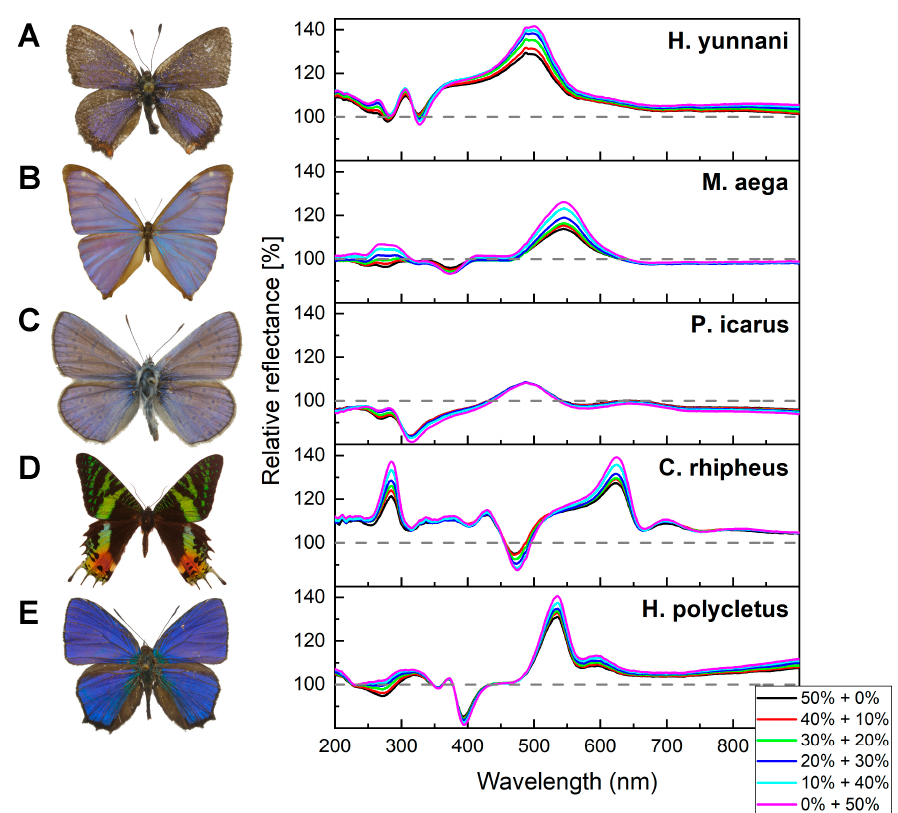
Figure 4. Optical responses of the wings of five species (photographs are not to scale) were investigated when mixtures of acetone and ethanol vapors were applied. ( A ) H. yunnani , ( B ) M. aega , ( C ) P. icarus , the green parts of ( D ) C. rhipheus , and ( E ) H. polycletus all showed similar color change behavior: the optical responses of the mixtures fell between the color change signals of the pure solvents. The broken lines show the initial relative reflectance spectra used as a reference (100%).